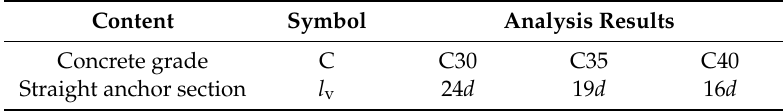
Table 7. Anchorage lengths of the ring joint.